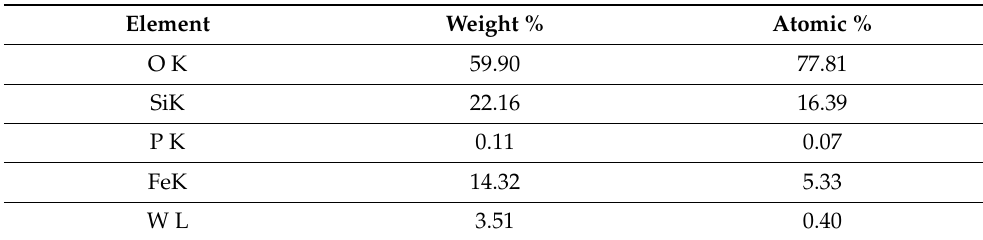
Figure 1. SEM microphotographs of ( a ) Fe 3 O 4 , ( b ) Fe 3 O 4 @ SiO 2 , and ( c ) Fe 3 O 4 @ SiO 2 @HPW . Table 1. EDS analysis of the Fe 3 O 4 @SiO 2 @HPW